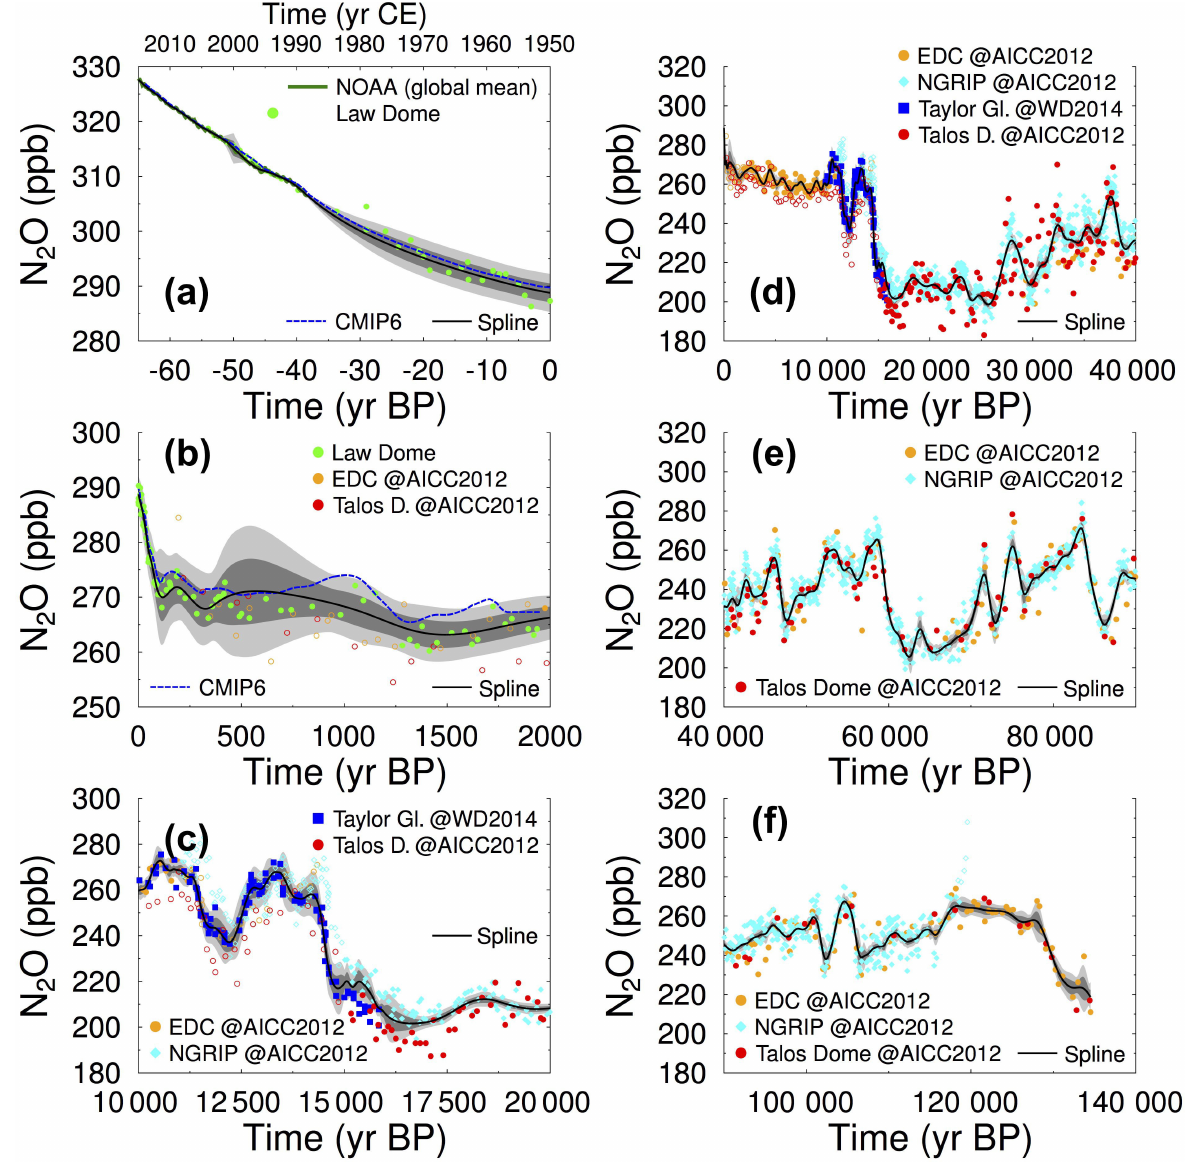
Figure 6. Details of the N 2 O spline. Light and dark grey bands around the spline represent ± 1 σ and ± 2 σ , respectively. (a) Instrumental times (1950–2016CE); (b) 0–2000BP; (c) Termination I; (d) 0–40kyrBP without the Law Dome data showing the anthropogenic rise; (e) 40–90kyrBP; (f) 90–140kyrBP. Filled symbols: data taken for spline; open symbols: data not taken for spline. See text for further details. Dashed line labelled CMIP6 in panels (a) and (b) is the compiled N 2 O record to be used in CMIP6 experiments for the last 2kyr (Meinshausen et al.,